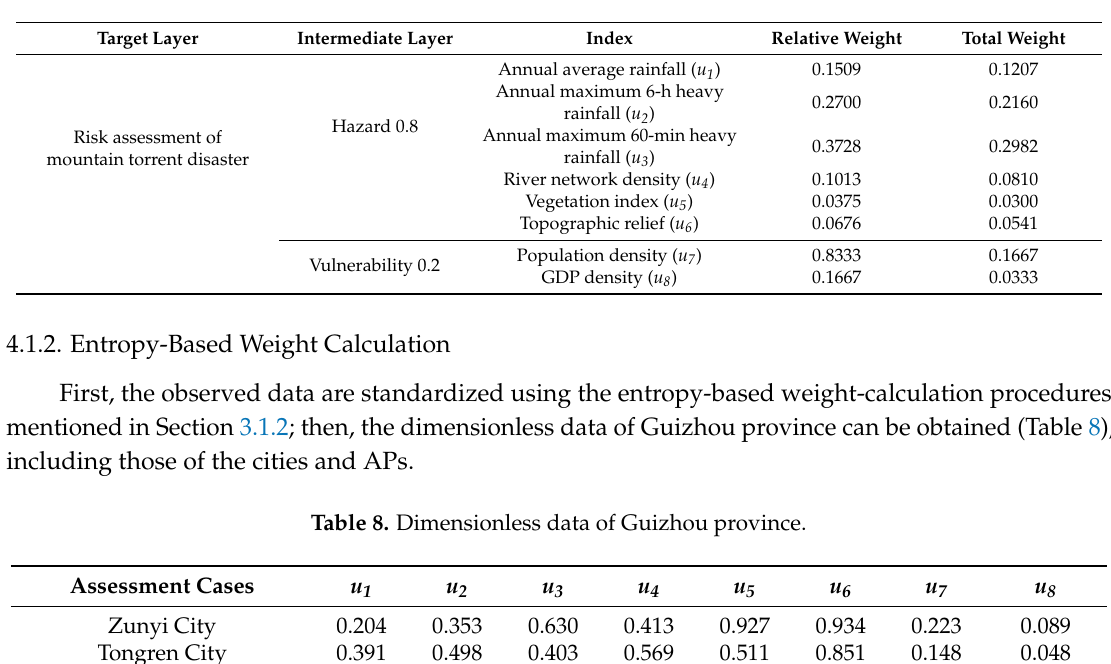
Table 7. Ultimate weight of each index for risk assessment of mountain torrent disaster.